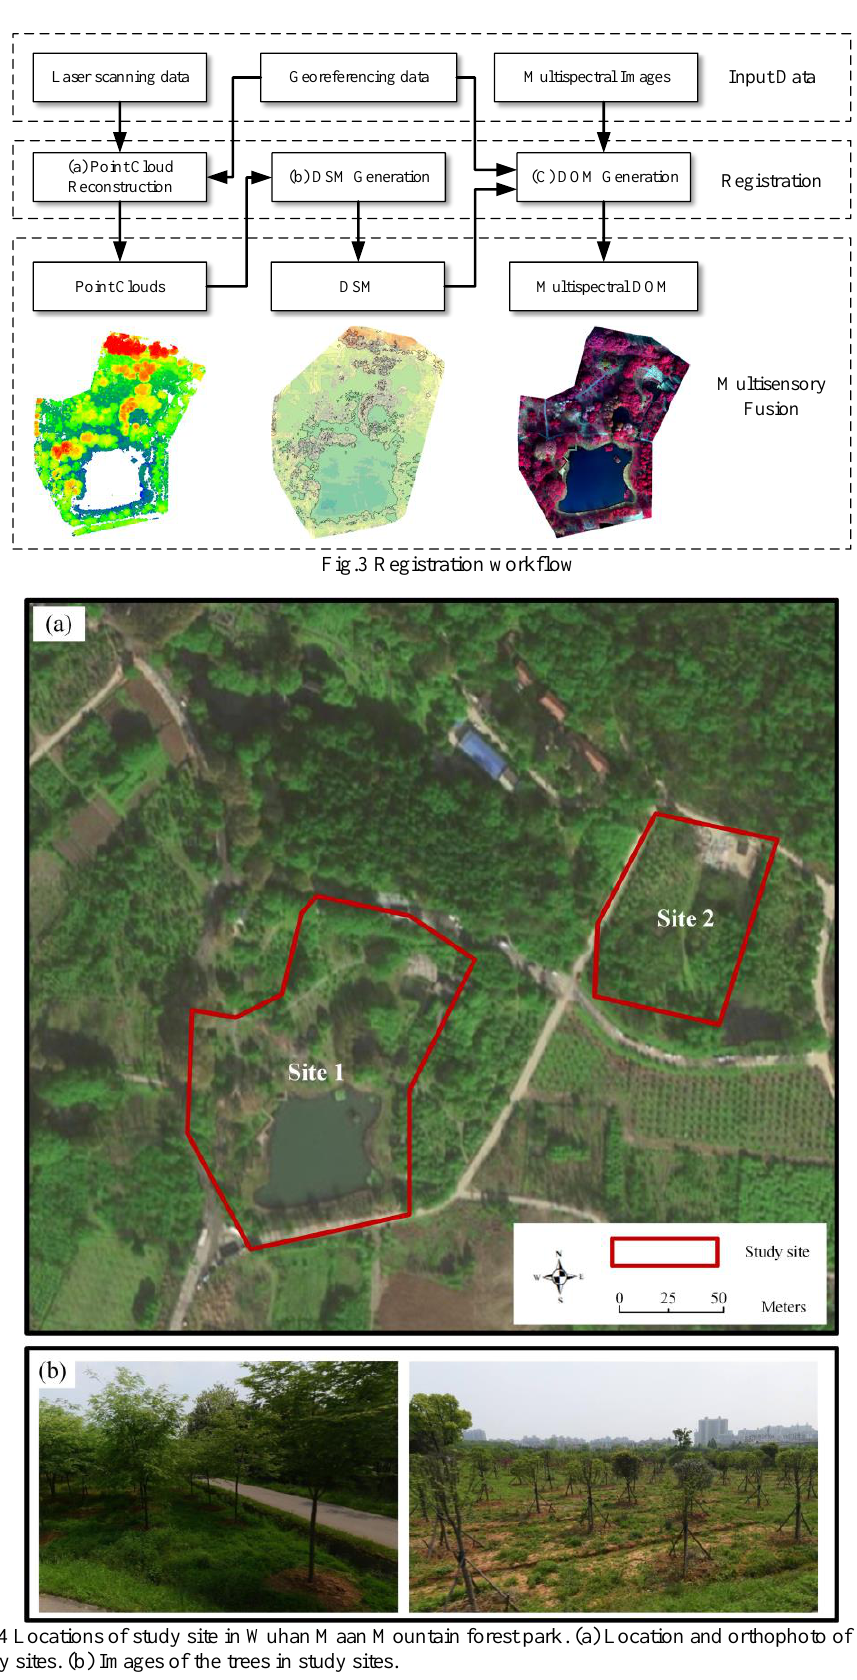
Fig.4 Locations of study site in Wuhan Maan Mountain forest park. (a) Location and orthophoto of the study sites. (b) Images of the trees in study